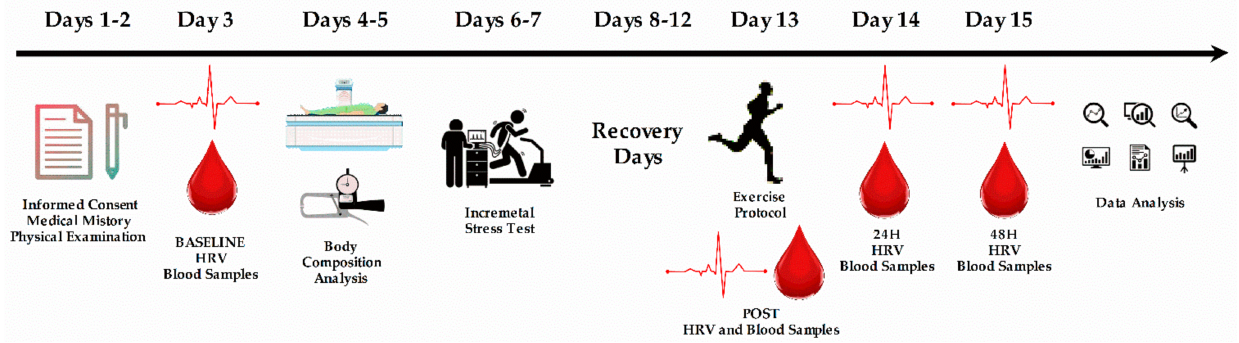
Figure 1. Experimental